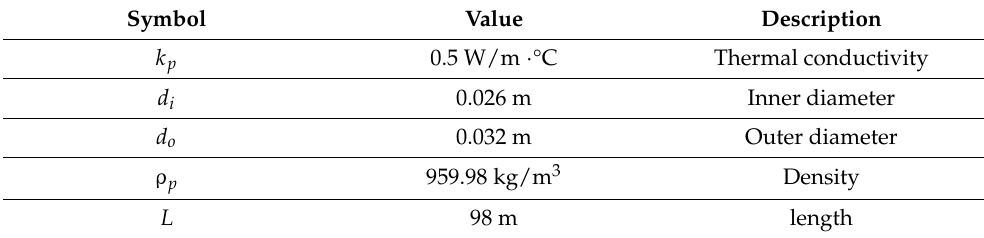
Table 2. HDPE piping system geometric characteristics.